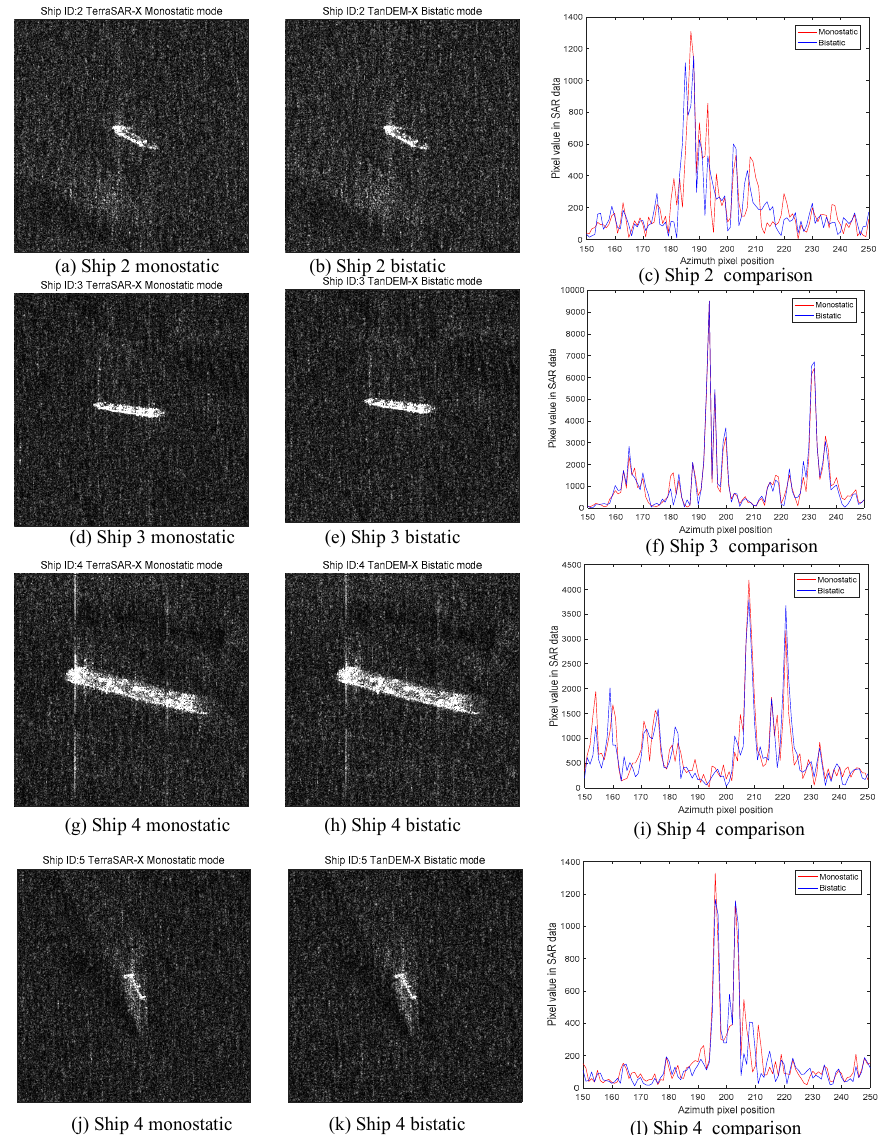
Figure 29. Comparison results of ship 2, 3, 4 and 5 ( a ) Ship 2 monostatic; ( b ) Ship 2 bistatic; ( c ) Ship 2 comparison curves; ( d ) Ship 3 monostatic; ( e ) Ship 3 bistatic; ( f ) Ship 3 comparison curves; ( g ) Ship 4 monostatic; ( h ) Ship 4 bistatic; ( i ) Ship 4 comparison curves; ( j ) Ship 5 monostatic; ( k ) Ship 5 bistatic; ( l ) Ship 5 comparison curves.